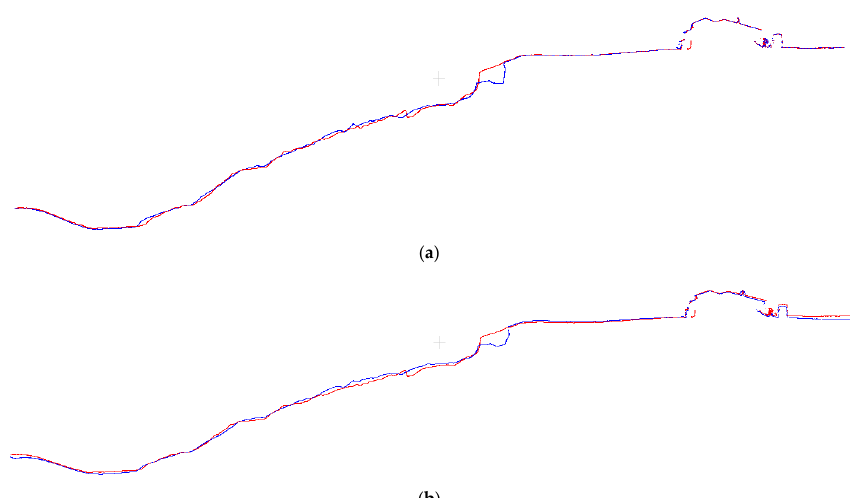
Figure 10. Registration results of a cross-section diagonally across the Lethbridge landslide area between the epoch from 2014 (red) and the epoch captured in 2015 (blue). ( a ) Cross-section along the study area after the registration using the proposed registration method; ( b ) Cross-section along the study area after the registration using ICPP-based registration method.